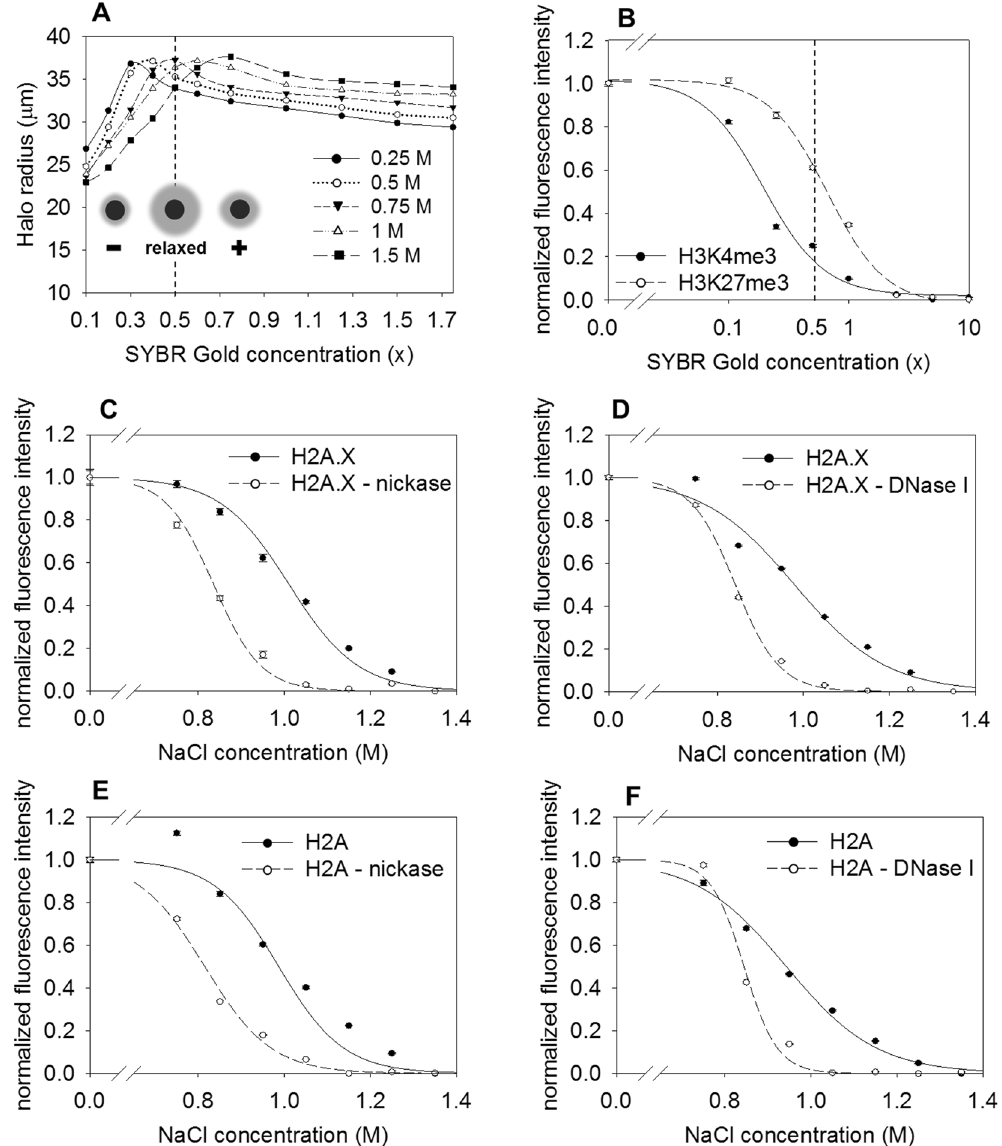
Figure 4. Superhelicity relaxation induced nucleosome destabilization. ( A and B ) Comparison of the changes of superhelicity ( A ) and nucleosome destabilization ( B ) in the case of the intercalator SYBR Gold, in Jurkat cells. ( A ) Determination of the relaxation concentration of SYBR Gold. The average halo radius of G1 phase cells was measured at increasing dye concentrations and in the presence of different salt concentrations (see “winding assay” in Methods). The inset shows the principle of the nuclear halo winding assay: As the intercalator concentration increases, the negatively supercoiled DNA loops get relaxed (halo size is increased), then overwound (i.e. becoming positively supercoiled with a decreased halo size). ( B ) Histone elution using SYBR Gold at 0.75 M NaCl. The SYBR Gold concentration inducing complete halo relaxation at 0.75 M NaCl concentration and where the DNA loops are completely relaxed is shown by the dashed line on both panels. (See also: Supplementary Fig. S8A) The concentration of the intercalators are shown in a logarithmic scale. Normalization was as described in the Methods. ( C and D ) Effect of nickase ( C ) and DNase I ( D ) treatment on H2A.X salt elution in HCT116 nuclei. (See also: Supplementary Fig. S8C and D). ( E and F ) Effect of nickase ( E ) and DNase I ( F ) treatment on H2A salt elution in HCT116 nuclei. (See also: Supplementary Fig. S8E and F). The elution curves refer to G1 phase cells gated according to their DNA fluorescence intensity distribution. Error bars represent SEM of ~600 G1 nuclei measured by